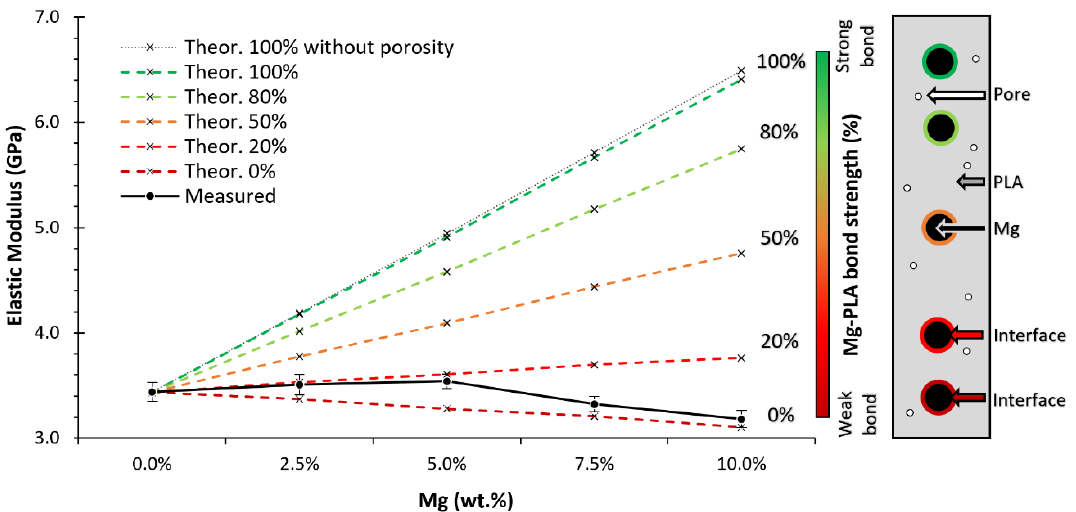
Figure 10. Elastic modulus versus the Mg content and its theoretical value, considering the porosity and the PLA-Mg bond strength. A bond strength of 100% refers to a perfect interface in which all loads are transmitted to the Mg particle; 0% represents a weak interface where loads are not transferred from the PLA-matrix to the Mg particle.